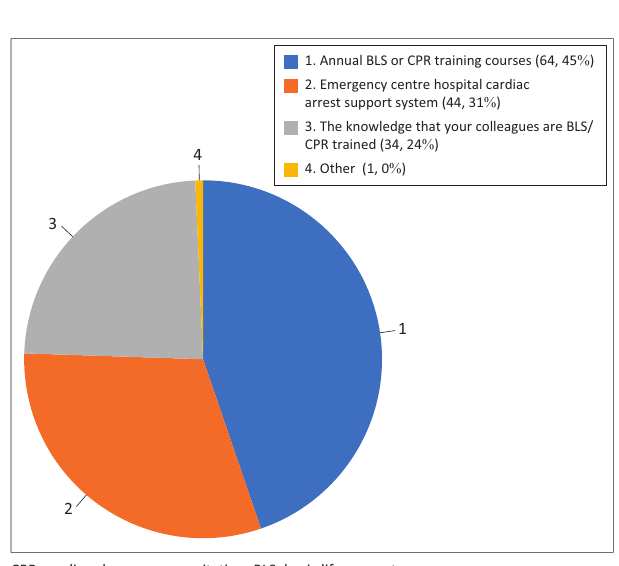
FIGURE 2: Factors considered to increase confidence of basic life support